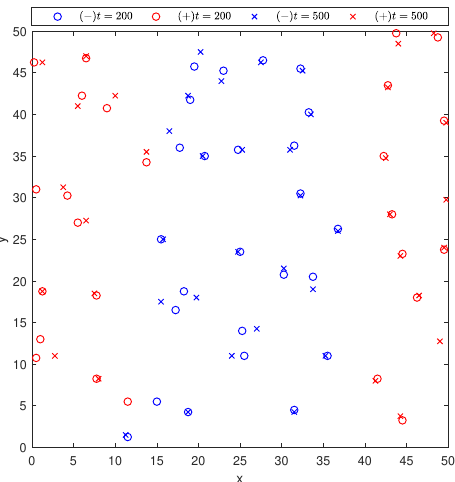
Figure 3. The positions of magnetic fluxoids at different times ( t = 200 and t = 500 ) with τ Q = 20 and B 0 = 1 from the attached movie M2.avi. The circles indicate the positions of the magnetic fluxoids at t = 200 , and the crosses indicates the positions of the magnetic fluxoids at t = 500 . Red color represents positive magnetic fluxoids and blue color represents negative magnetic